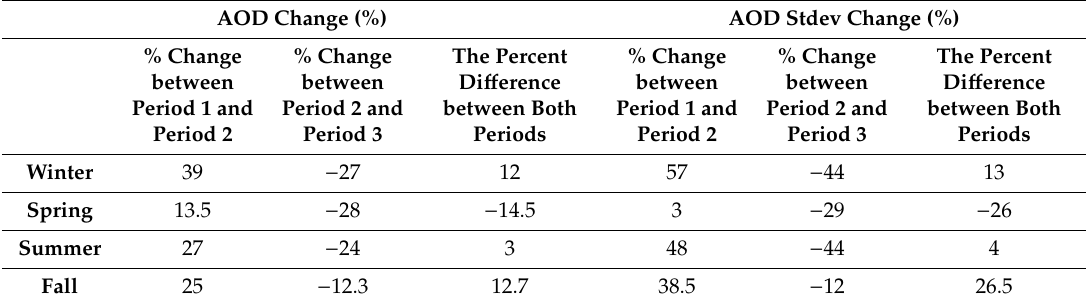
Table 2. Percent changes in AOD and AOD stdev over military sites (N = 65–70) between Periods 1 and 2 and Periods 2 and 3. a AOD Change (%) AOD Stdev Change (%)